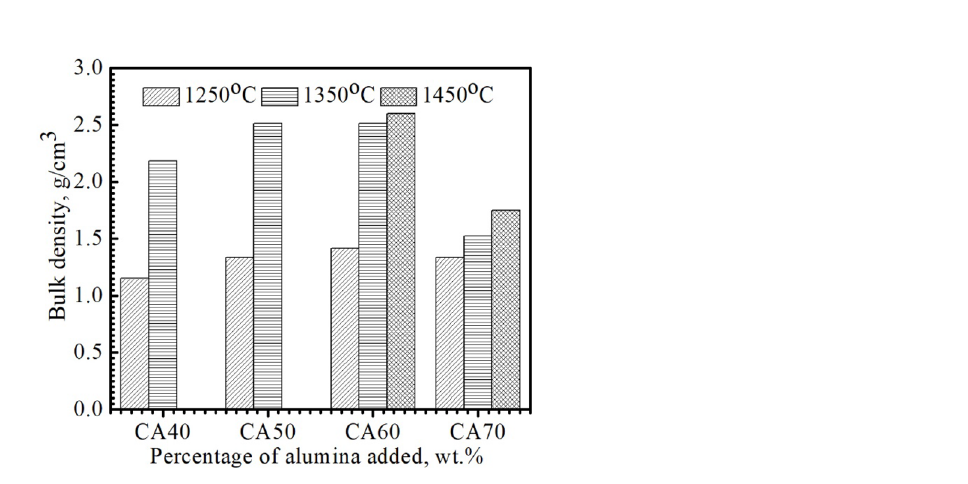
Figure 5. Bulk density of the compacted specimens sintered at 1250, 1350 °C and 1450